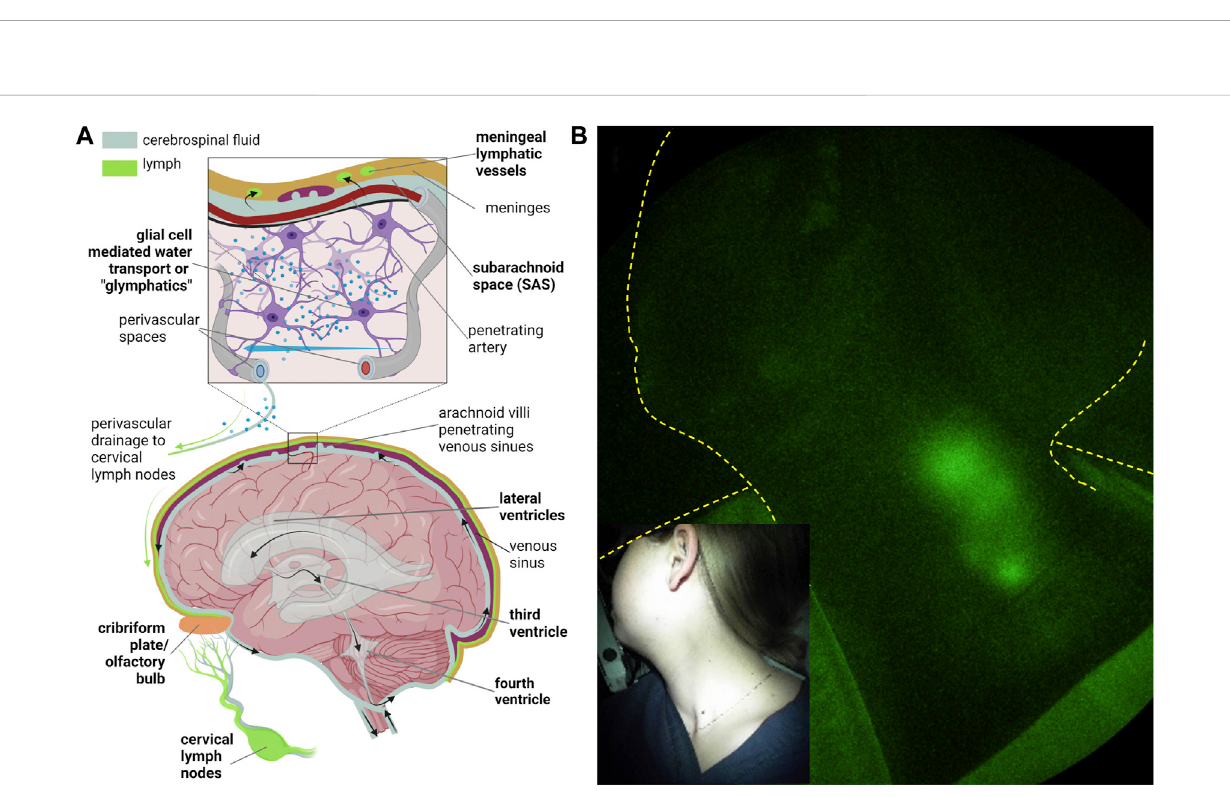
FIGURE 11 (A) Routes of cerebrospinal fl uid (CSF) egress through the ventricular space and into the peripheral lymphatics and CSF-interstitial exchange due to glial-mediated transport (i.e., glymphatics) from arterial to venous perivascular spaces that ultimately drain into the cervical lymphatics. Created with BioRender. (B) NIRF-LIvisualizationofjugularlymphnodechainfollowinginjectionintopalatinetonsils.Reproducedfromstudypublishedin(Rasmussen et al.,